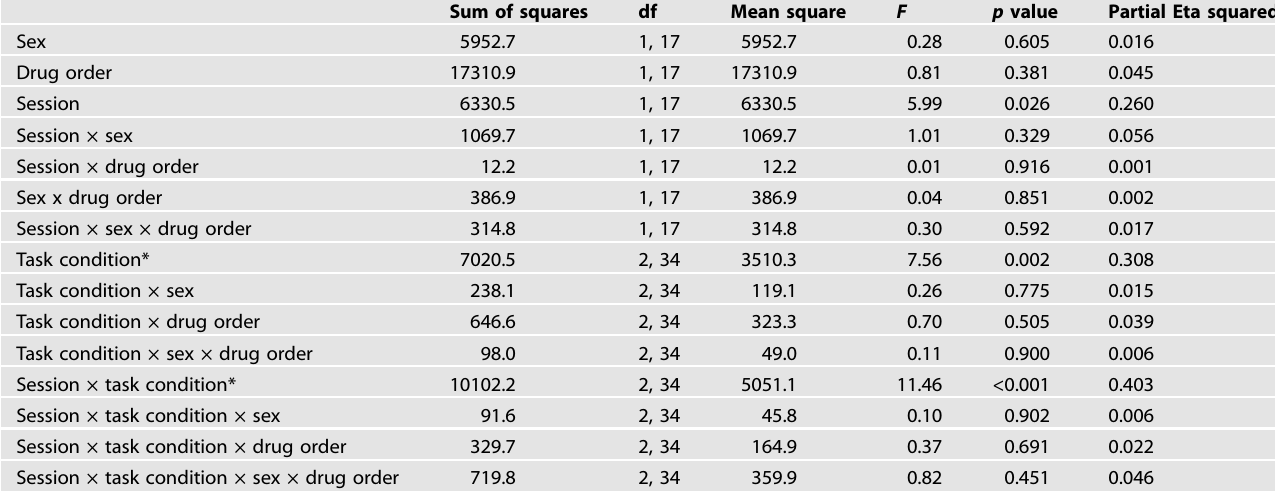
Table 2. Results of omnibus repeated measures ANOVA.